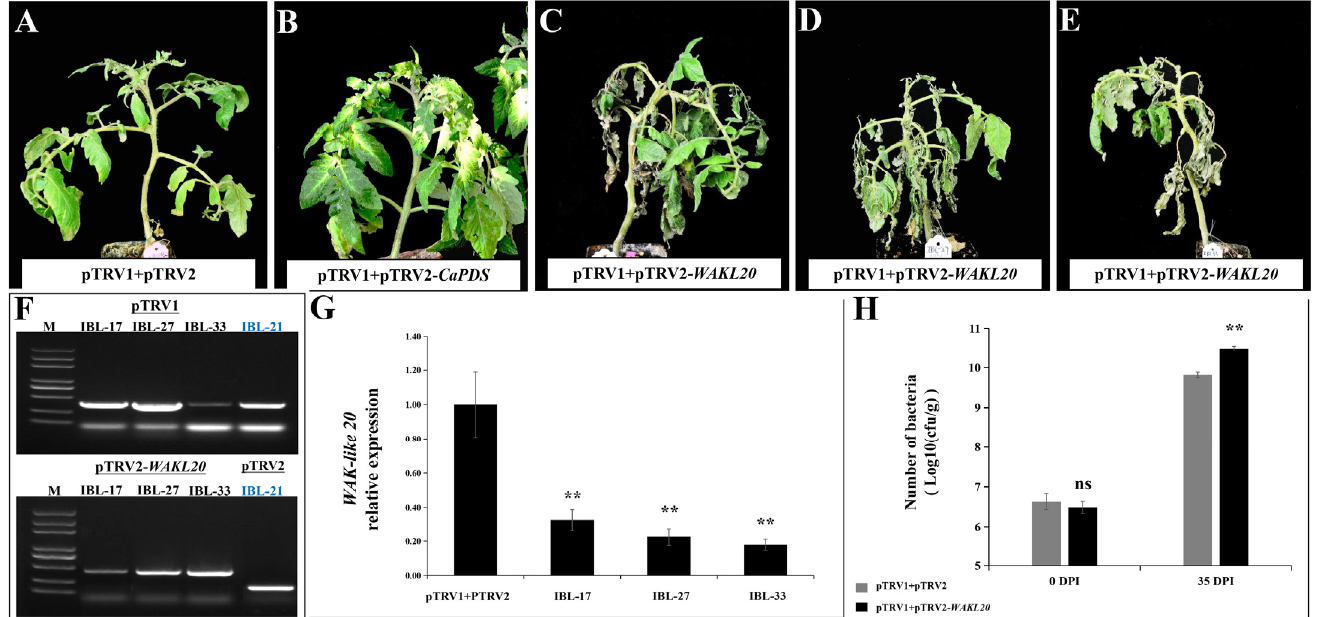
Figure 8. Silencing of WAKL20 in tomato plants led to disease susceptibility to the Cm infection. ( A ) Phenotype of the empty vector plant (IBL-21) at 35 dpi. ( B ) The positive control CaPDS -silenced plants were light-bleached in leaves after 30 days. ( C – E ) The disease symptoms of three WAKL20 - silenced plants at 35 dpi (IBL-17, IBL-27, and IBL-33). ( F ) PCR-based detection of pTRV1 and pTRV2- WAKL20 plasmids in three silenced plants and negative control pTRV2 plant. ( G ) Relative expression of WAKL20 in leaves collected from injected plants with pTRV1 + pTRV2 and pTRV1 + pTRV2- WAKL20 (IBL-17, IBL-27, and IBL-33), respectively. Significant differences were determined using independent-samples t -test ( p < 0.01). ** denotes very significant differences compared to the control plants based on independent-samples t -test ( p < 0.01). ( H ) Bacterial growth in WAKL20 -silenced plants at 35 dpi. ** denotes very significant differences between the control and WAKL20 -silenced plants using independent-samples t -test ( p < 0.01), ns denotes no significant differences between the control and WAKL20 -silenced plants ( p > 0.05).